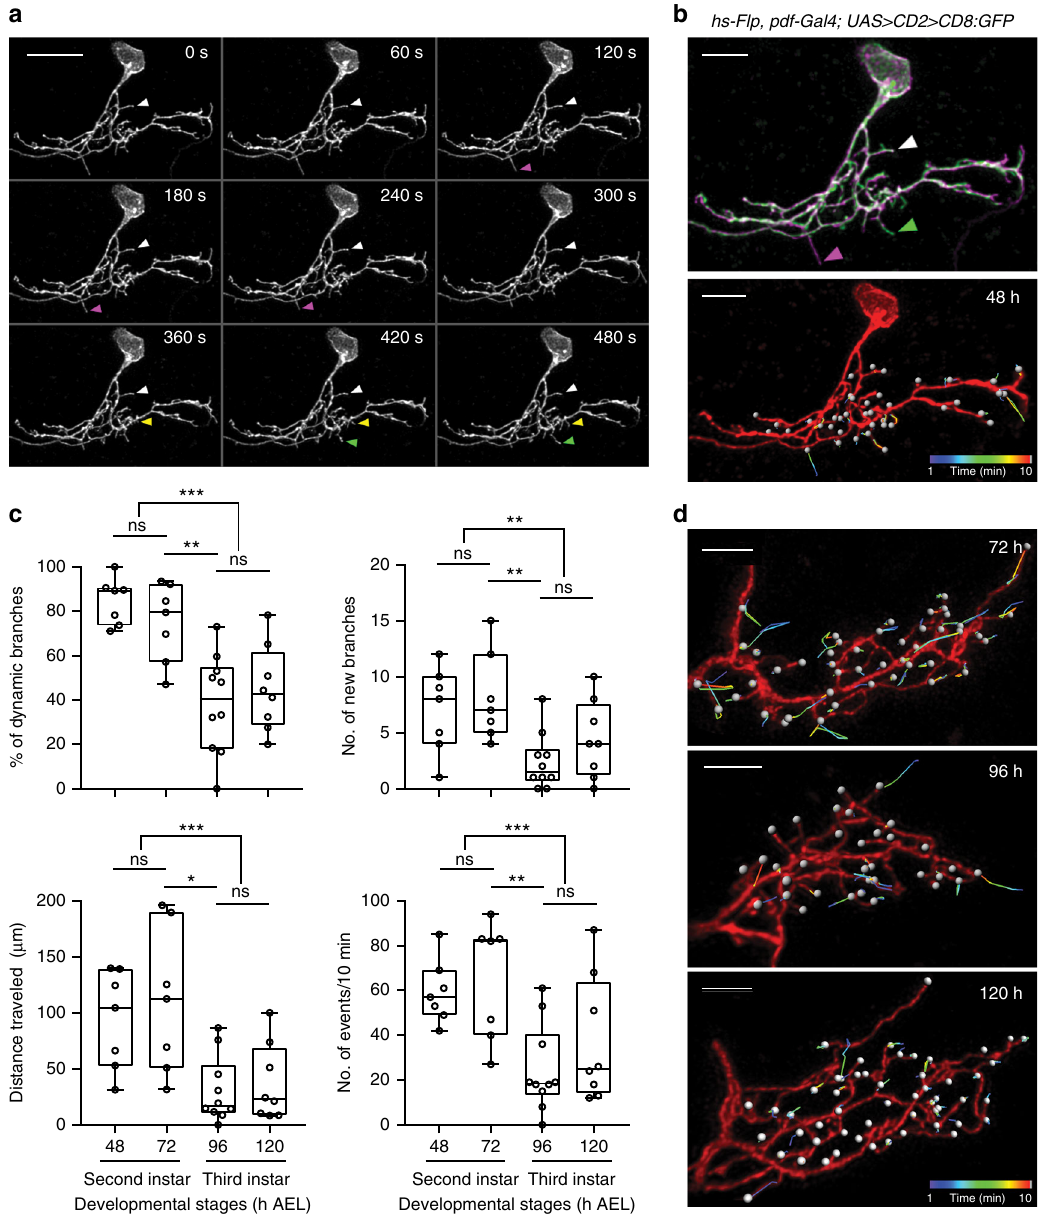
Fig. 1 Time-lapse 3D imaging of dynamic fi lopodia on developing LNv dendrites. a Examples of extension (green), retraction (magenta), newly appeared (yellow), and stable (white) branches on the dendritic arbor of a single-labeled LNv. Scale bar, 10 μ m. A representative Z-projected time series is shown. b 4D tracing of branch tips provides accurate representations of dynamic events on the entire dendritic arbor. Top: Overlay of the fi rst (magenta) and last frame (green) of the Z-projected time series. Bottom: The 3D rendering image of tracking trajectories generated by movements of dynamic fi lopodia. Branch tips are marked by white spots. c Decreased dendrite dynamics in mature neurons (3 rd instar, 96 and 120 h) as compared to young neurons (2 nd instar, 48 and 72 h). Transitions from dynamic to stable state occur between 72 to 96 h AEL. Data are presented as box plot (box, 25 – 75%; center line, median) overlaid with dot plot (individual data points). n = 7, 7, 10, and 8 for 48, 72, 96, and 120 h, respectively. Statistical signi fi cance was assessed by one-way ANOVA with Tukey ’ s post hoc test for all time points and two-tailed Student ’ s t -test for grouped comparisons (2 nd vs 3 rd instar). P -value from Tukey ’ s test for 72 vs 96 h is reported. The percentage of dynamic branches (Top left): ANOVA: F 3, 28 = 11.68, P < 0.001; Tukey ’ s: P = 0.002; t -test: t 30 = 5.834, P < 0.001. The number of newly appeared branches (Top right): ANOVA: F 3, 28 = 4.826, P = 0.008; Tukey ’ s: P = 0.01; t -test: t 30 = 3.553, P = 0.001. The distance traveled by branch tips (Bottom left): Tukey ’ s: P = 0.004; t -test: t 30 = 4.551, P < 0.001. The total number of events in 10 min (Bottom right): ANOVA: F 3, 28 = 5.8, P = 0.003; Tukey ’ s: P = 0.006; t -test: t 30 = 3.997, P < 0.001. ns, not signi fi cant, *P < 0.05, **P < 0.01, ***P < 0.001. d Representative 3D rendering images of tracking trajectories generated by movements of dynamic fi lopodia in single-labeled LNvs collected at 72, 96, and 120 h. Scale bar, 5 μ